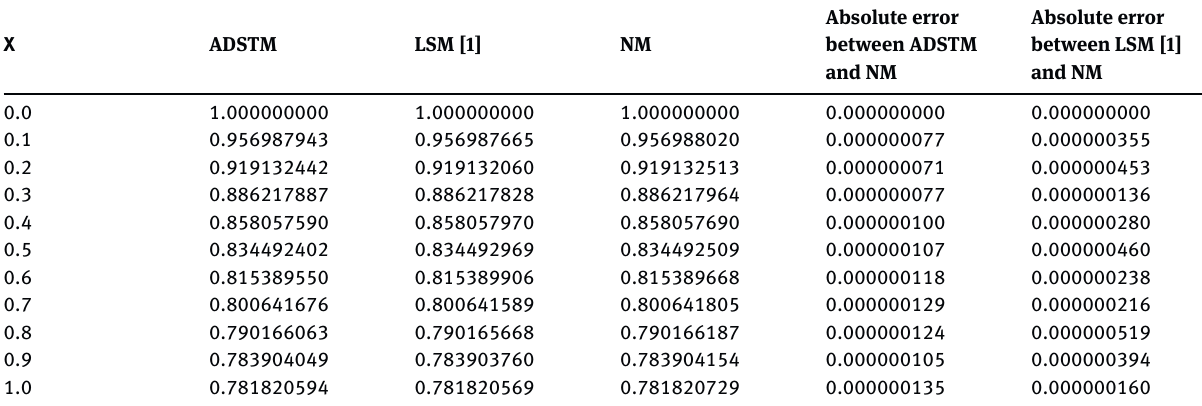
Table 1: Comparison of ADSTM solution, LSM [1] solution and the numerical method for dimensionless temperature θ ( ζ ) and for dimension-